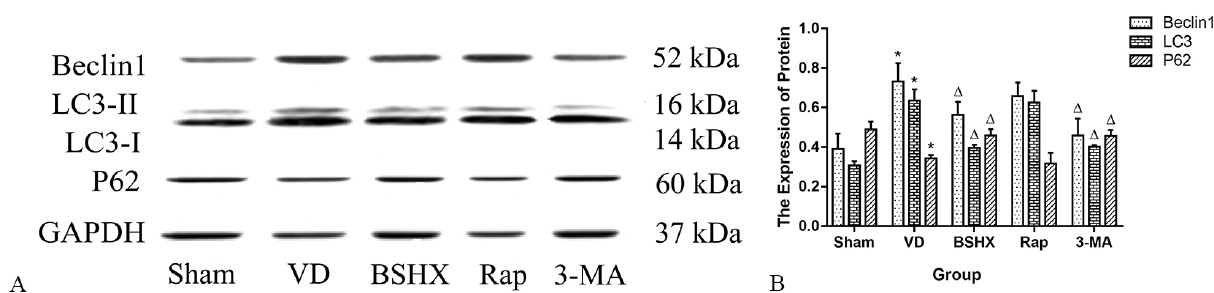
Fig. 9. Comparison of the expression levels of autophagy-related protein in rats. (A) The diagram of the western blot. (B) The diagram of expressions of autophagy-related protein. [Mean (SD), n = 4]. Compared with the Sham group, ∗ p < 0.05; Compared with the VD group, △ p < 0.05. The red columns represent Beclin1/GAPDH, and the green columns represent LC3-II/LC3-I and